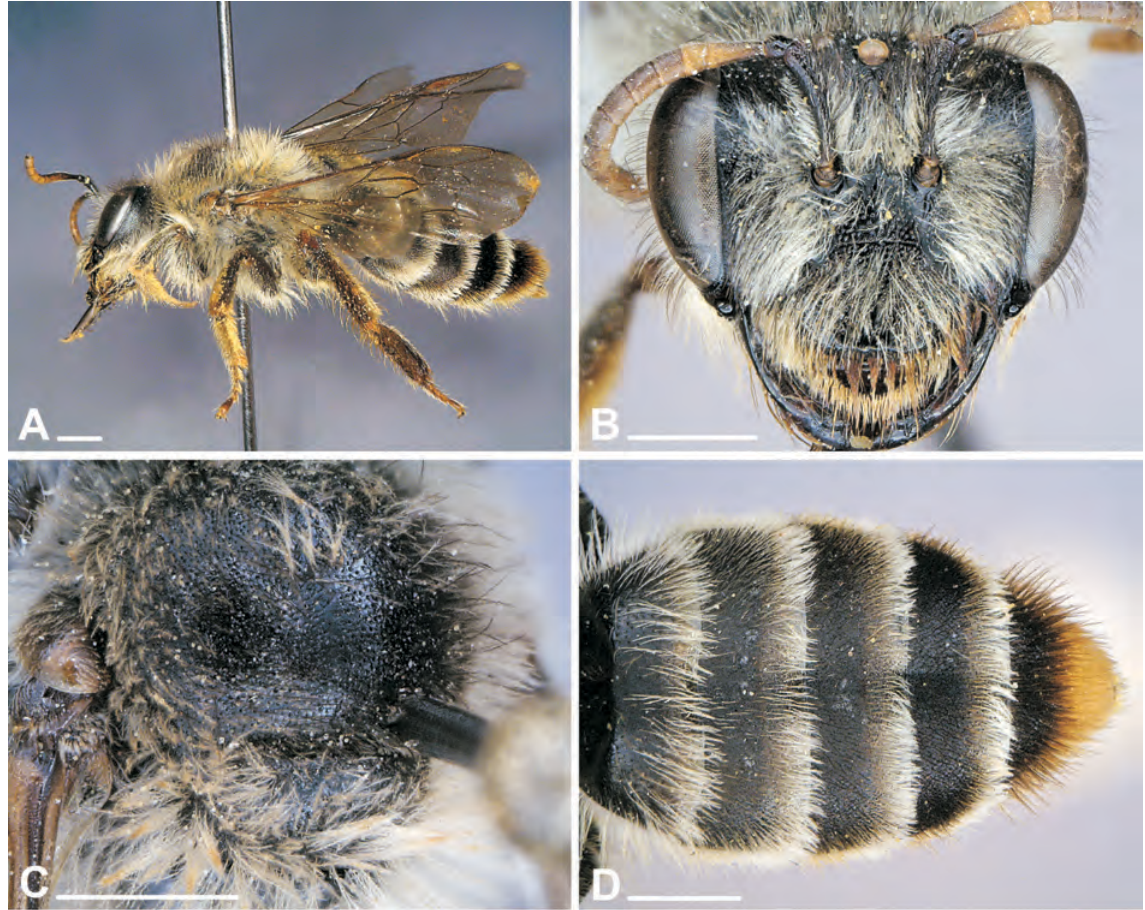
Fig. 10. Redivivoides namaquaensis sp. nov., ♀. A . lateral view. B . head. C . Scutum and scutellum. D . Metasoma (dorsal view). Scale bar: 1